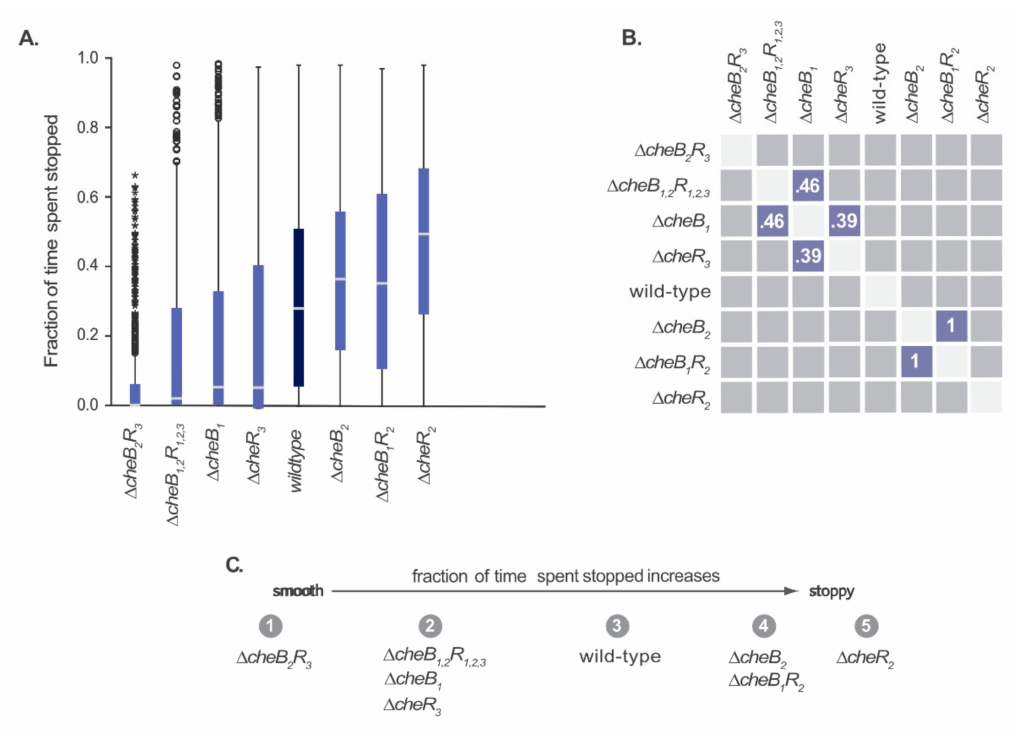
Figure 2. Steady-state swimming phenotypes of methylesterase and methyltransferase deletions in R. sphaeroides , calculated from tracks collected over 18 min of free swimming video (9 × 2 min), after censoring (see Methods 4.8). Table 2 shows the number of tracks analysed. ( A ) Box plots showing the distribution of fraction of time spent stopped. The box contains the interquartile range (middle 50% of values; IQR), the centre line indicates the median, and the whiskers indicate the minimum and maximum values no smaller / greater than 1.5 × IQR. Circles are outliers 1.5–3.0 × IQR and stars are extreme values more than 3.0 × IQR. ( B ) Post-hoc pairwise comparisons between distributions of fraction of time spent stopped for each mutant (following a Kruskal Wallis test with p < 0.001). Numbers indicate the p -value for that comparison. Comparisons not shown are p < 0.001. Blue squares indicate pairs that are not significantly di ff erent from one another ( p ≥ 0.05). ( C ) Strains grouped based on the proportion of time spent stopped, as judged by pairwise comparisons, from smooth swimming to very